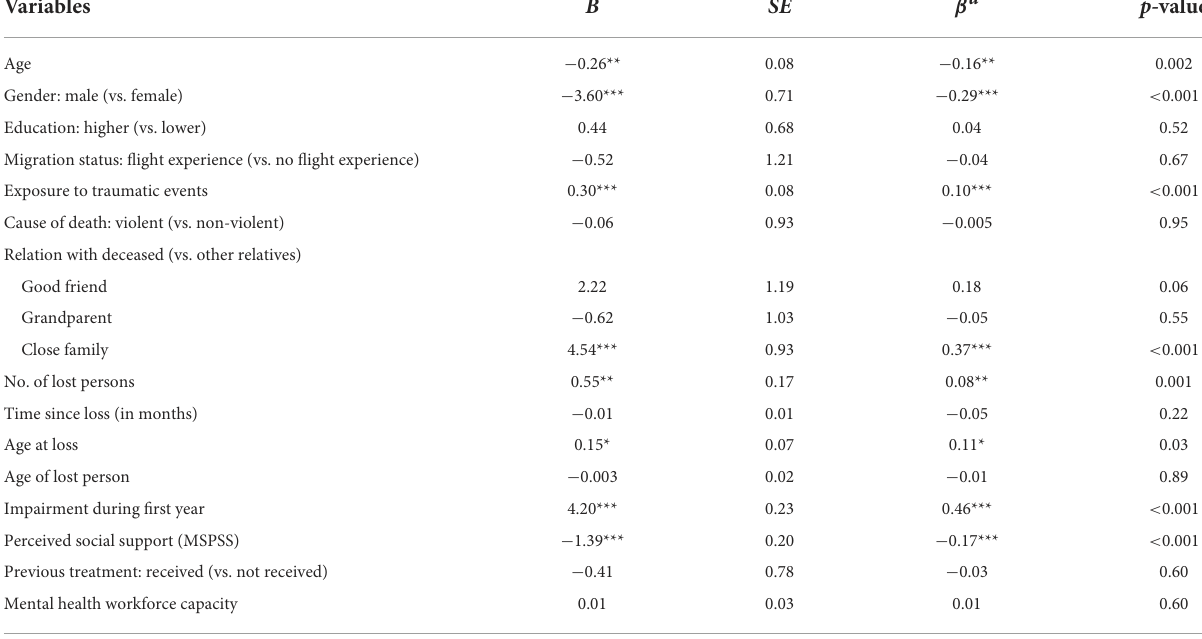
TABLE 2 Results of the multiple regression of demographic, loss-, trauma-, and support-related variables on the severity of prolonged grief. Variables B